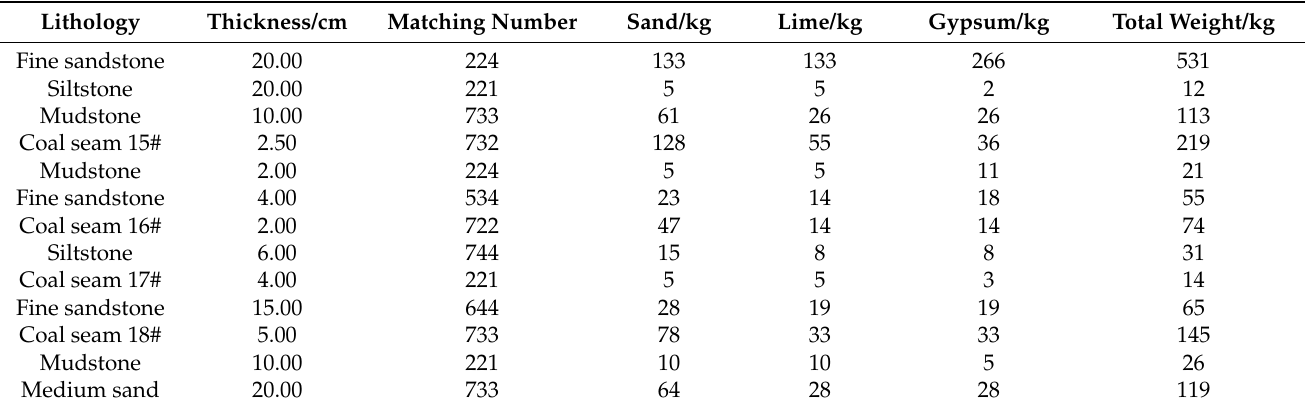
Table 1. Material ratio of similar simulation